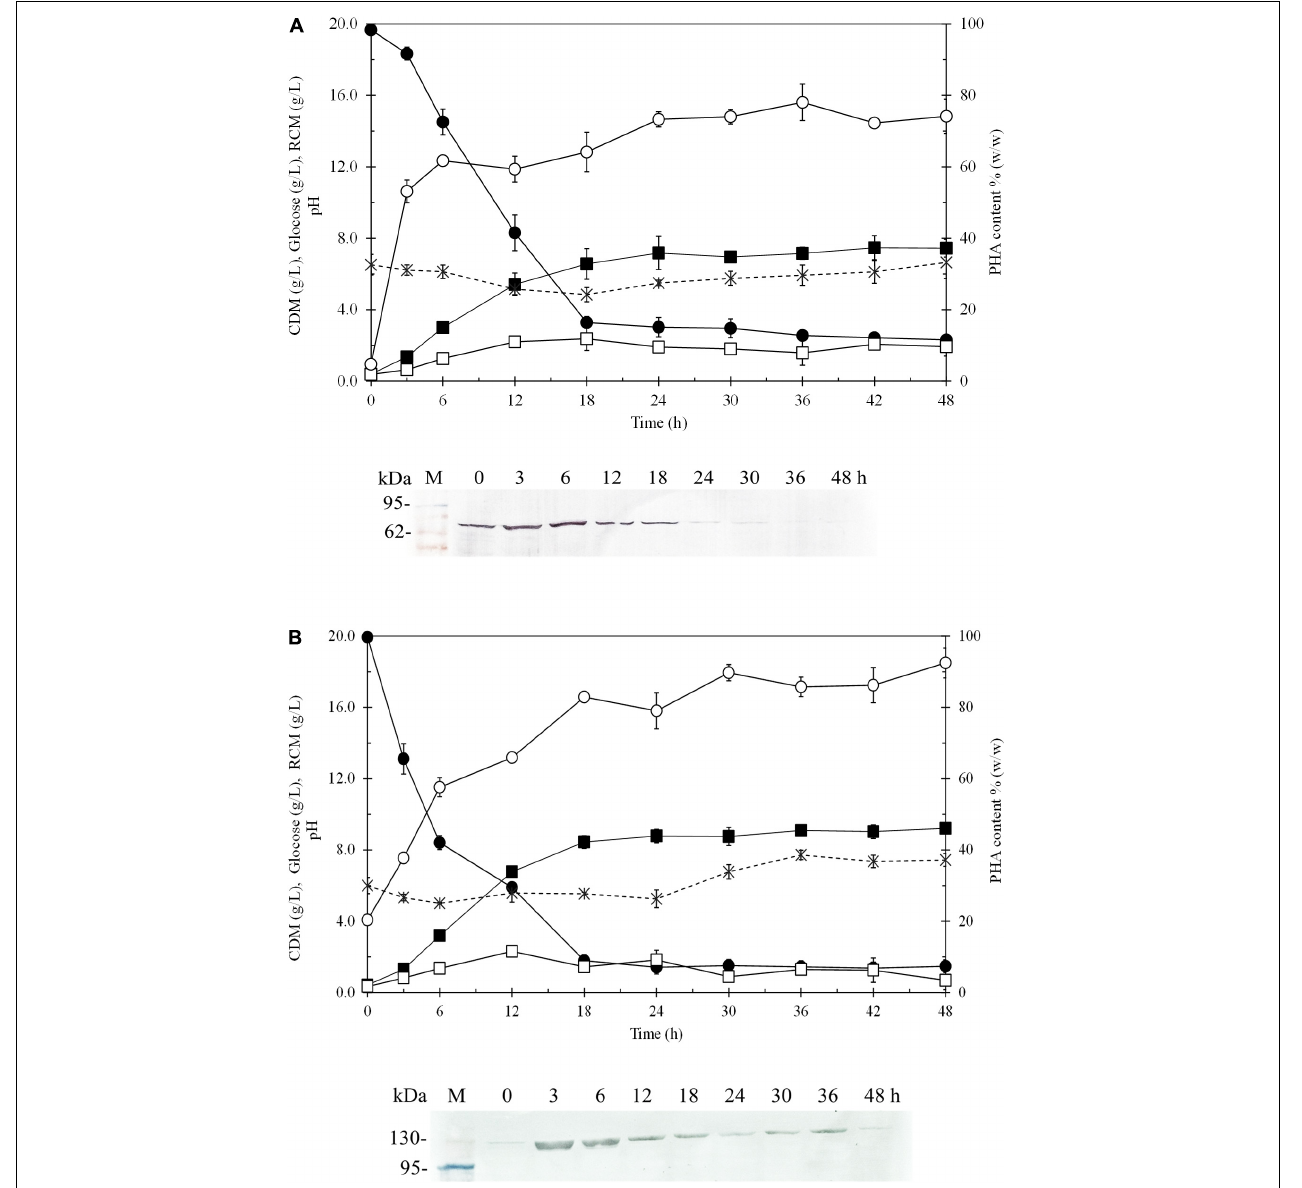
FIGURE 6 | Time courses of CDM (g/L), RCM (g/L), PHB (g/L), PHB content (% w/w), and glucose (g/L) and pH during batch cultivation in a 5-L fermenter under the short-induction method in a comparison between (A) E. coli JM109 (pColdI- phaCAB A - 04 ) and (B) E. coli JM109 (pColdTF- phaCAB A - 04 ). The band appearing in the western blot at the position corresponding to that of the His-tagged phaC A - 04 protein was 67 kDa in size for pColdI- phaCAB A - 04 , and the fusion protein of His-tagged phaC A - 04 and TF was 115 kDa in size. All the data are representative of the results of three independent experiments and are expressed as the mean values ± standard deviations (SDs). Symbols: closed square, CDM (g/L); closed circle, glucose (g/L); asterisks, pH; open square, RCM (g/L); open circle, PHB content (%